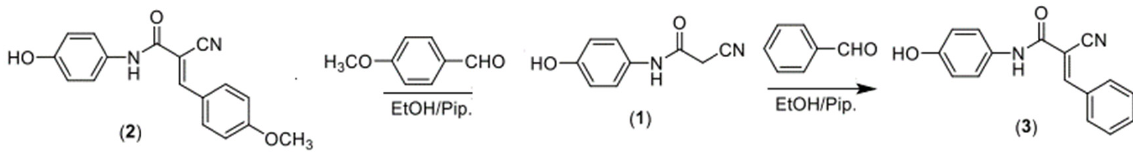
Figure 1. Synthesis of ACR-2 and ACR-3 compounds.